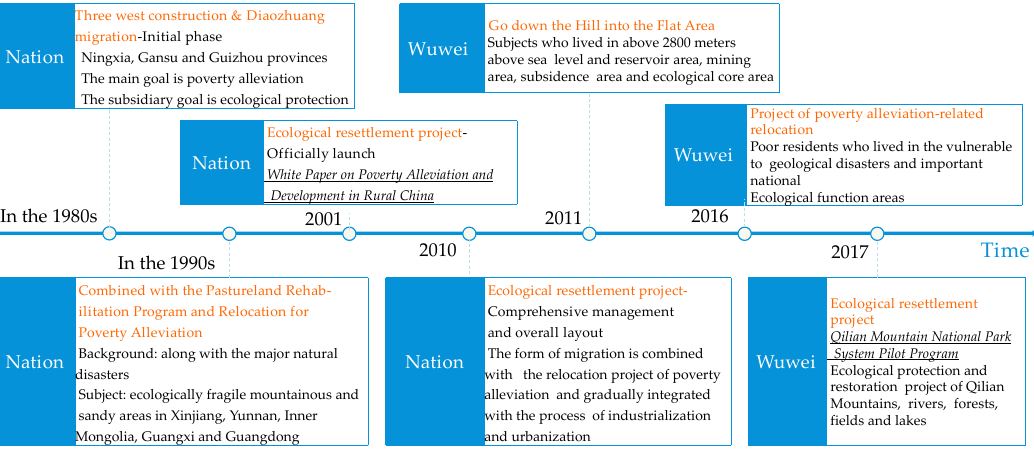
Figure 3. Ecological Resettlement Project timeline.